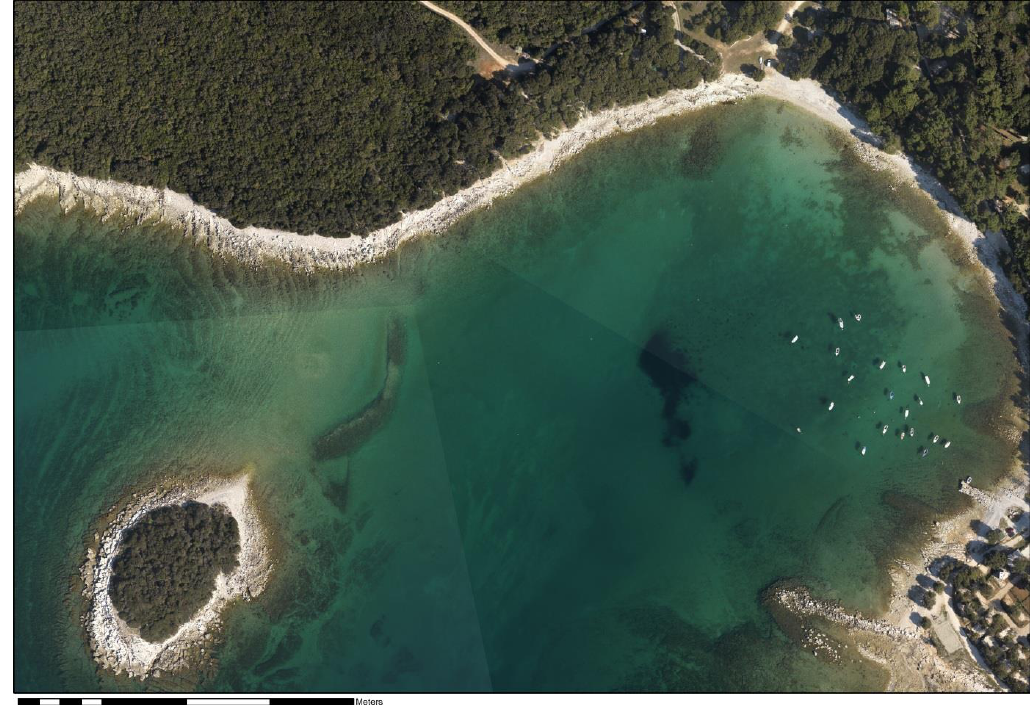
Figure 3. Case study area Kolone. Simultaneously acquired orthophoto mosaic showing the situation of the ancient harbour area. North is up.